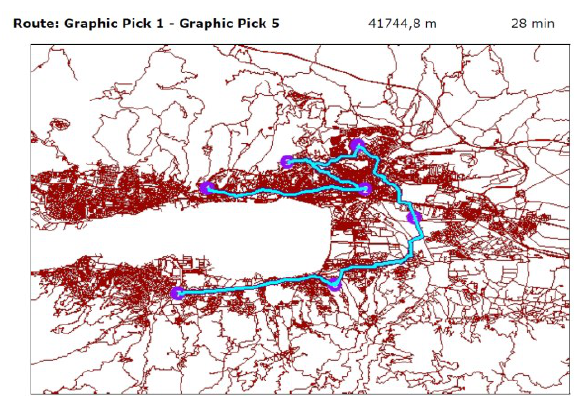
Figure 3. The route in which the test measures are